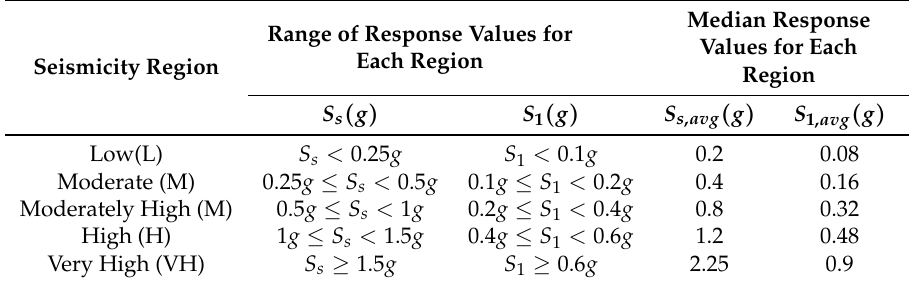
Table 1. Range and median MCE R spectral response acceleration values in each seismic region [13].